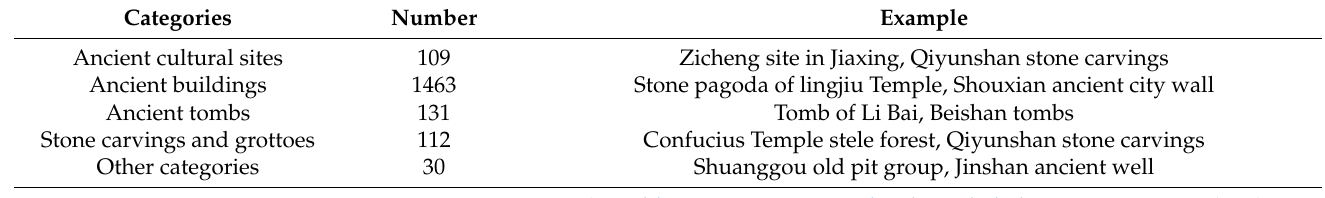
Table 1. Research data introduction.